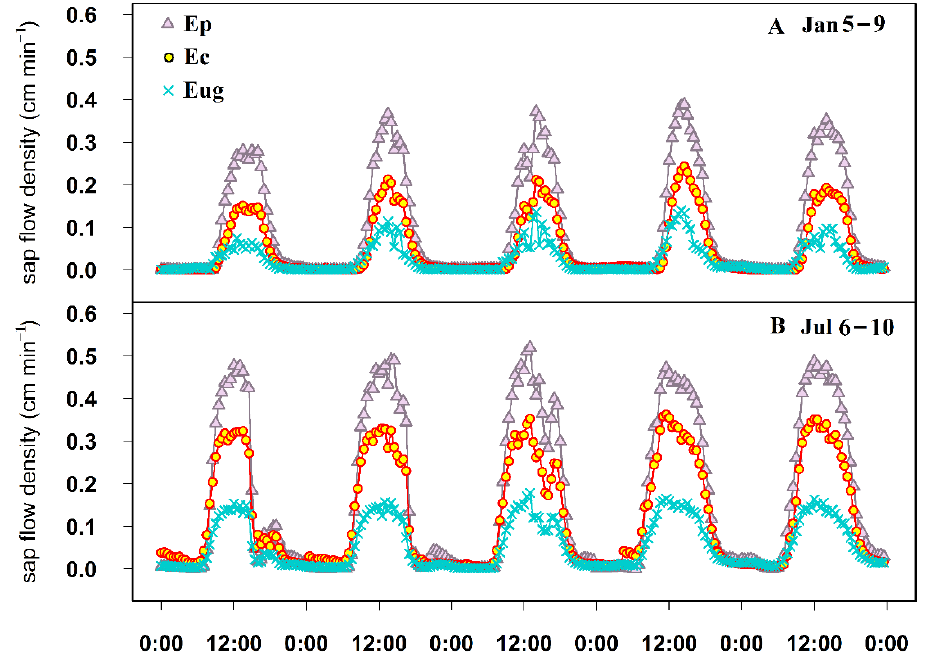
Figure 3. Diurnal variation of sap flow density in the three eucalyptus species plantations on sunny days during typical months for the ( A ) dry and ( B ) wet season. Ep, Ec, and Eug represent the eucalyptus species of E. pellita, E. camaldulensis, and E. urophylla × E. grandis , respectively.